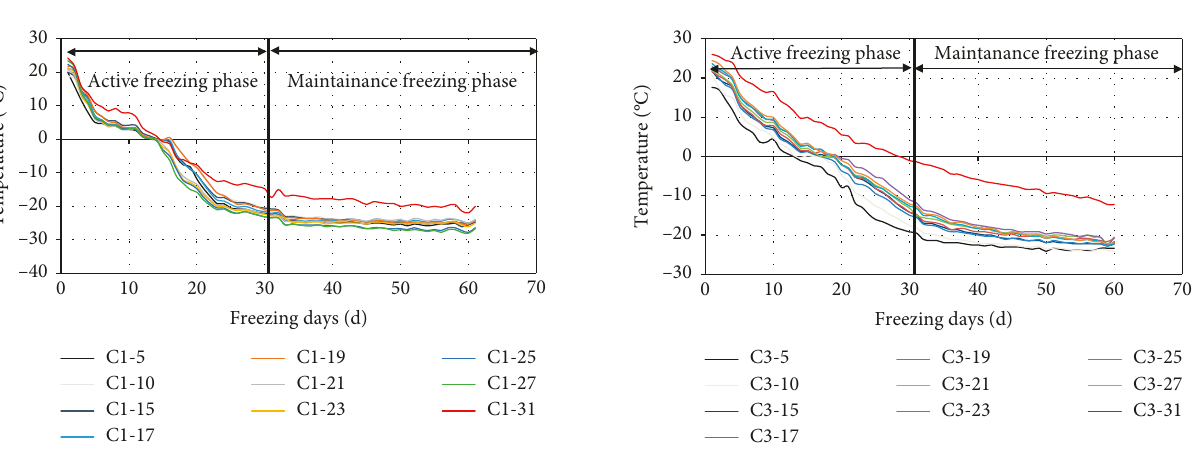
Figure 8: Curves of temperature and times at C1 temperature measuring hole.